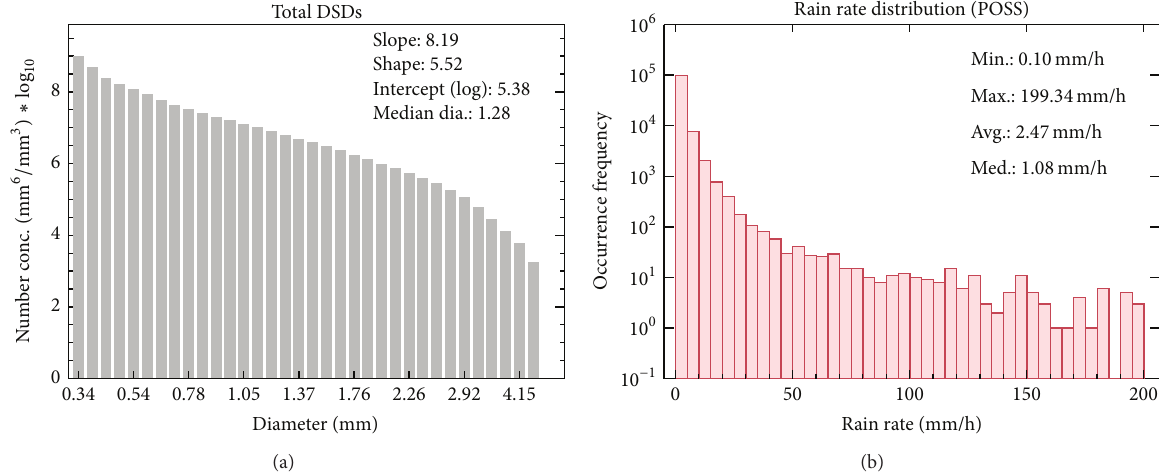
Figure 2: Histogram of (a) total number concentration with respect to the drop size and gamma parameters and (b) rain rate calculated using 114,105 samples of 1-minute DSD after quality